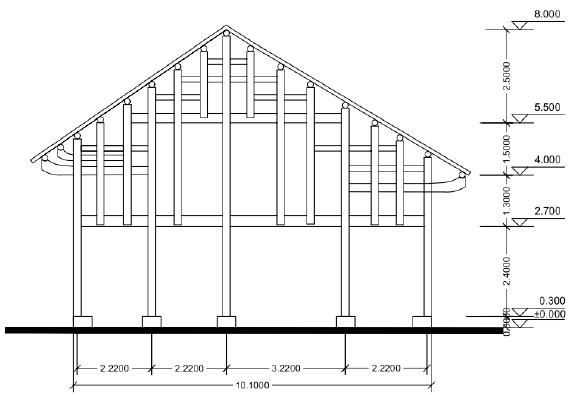
Figure 17. Section of Vernacular